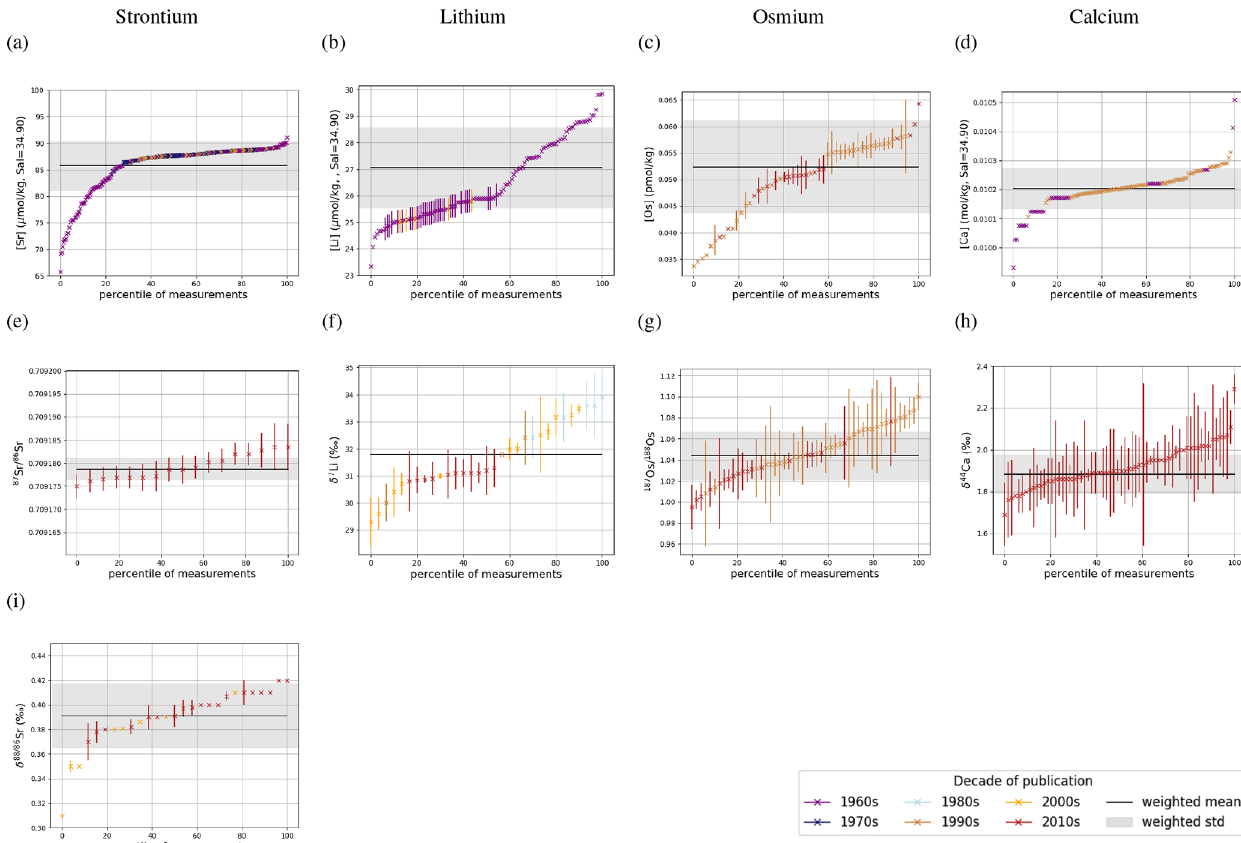
Figure 1. Sr (a, e, i) , Li (b, f) , Os (c, g) and Ca (d, h) composition of modern seawater. Shown are composites of all published measured concentrations (a–d) and isotope ratios (e-i) with reported errors. From these, we calculated mean concentrations and isotope ratios weighted by the reported error (the more uncertain a value, the less it contributes to the mean), which are indicated by horizontal lines. Shading indicates a single weighted standard deviation around the means. Data are taken from Angino et al. (1966), Fabricand et al. (1967), Bernat et al. (1972), Brass and Turekian (1974), De Villiers (1999), Pearce et al. (2015), Mokadem et al. (2015), and the compilation of Wakaki et al. (2017) for Sr; Angino and Billings (1966), Fabricand et al. (1967), Chan (1987), Chan and Edmond (1988), You and Chan (1996), Moriguti and Nakamura (1998), Tomascak et al. (1999), James and Palmer (2000), Košler et al. (2001), Nishio and Nakai (2002), Hall (2002), Bryant et al. (2003), Pistiner and Henderson (2003), Millot et al. (2004), Choi et al. (2010), Pogge von Strandmann et al. (2010), Phan et al. (2016), Lin et al. (2016), Henchiri et al. (2016), Weynell et al. (2017), Fries et al. (2019), Gou et al. (2019), Hindshaw et al. (2019), Murphy et al. (2019), and Pogge von Strandmann et al. (2019b) for Li; Levasseur et al. (1998), Woodhouse et al. (1999) and Gannoun and Burton (2014) for Os; and Fabricand et al. (1967), De Villiers (1999), and Fantle and Tipper (2014) for Ca. The decade of publication is indicated by color as measurement techniques for some metals and isotopes have improved over time. Concentrations of Sr, Li and Ca are normalized to a salinity of 34.90. Os concentrations could not be salinity-normalized because of missing salinity measurements at one out of three measurement sites (Woodhouse et al.,